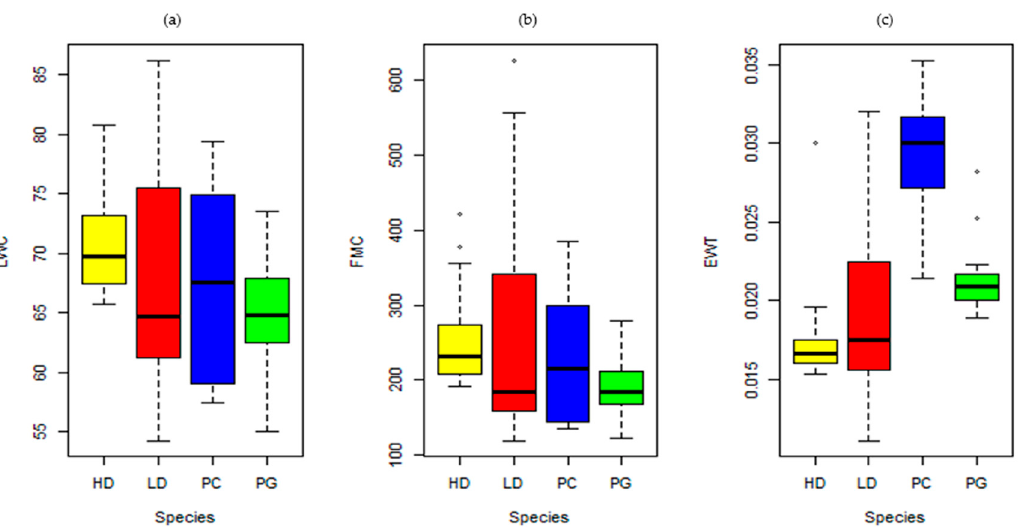
Figure 3. Boxplot of leaf-level functional traits. Water content: ( a ) LWC (%) = liquid water content; ( b ) FMC (%) = fuel moisture content; and ( c ) EWT (g cm − 2 ) = equivalent water thickness; were the species are: HD (yellow) = Hovenia dulcis ; LD (red) = Luehea divaricata ; PC (blue) = Psidium cattleianum ; PG (green) = Psidium guajava . * Indicates outliers.